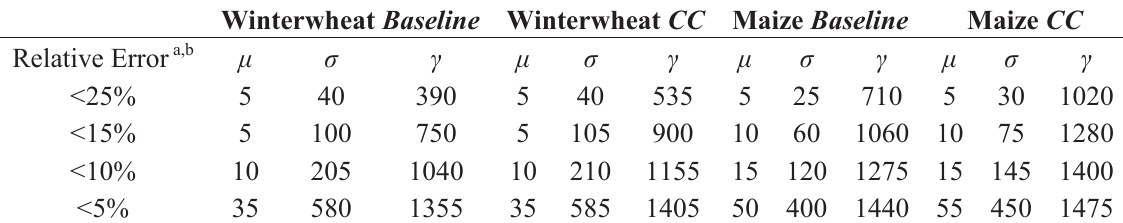
Table 2. Minimum sample sizes for different relative errors at